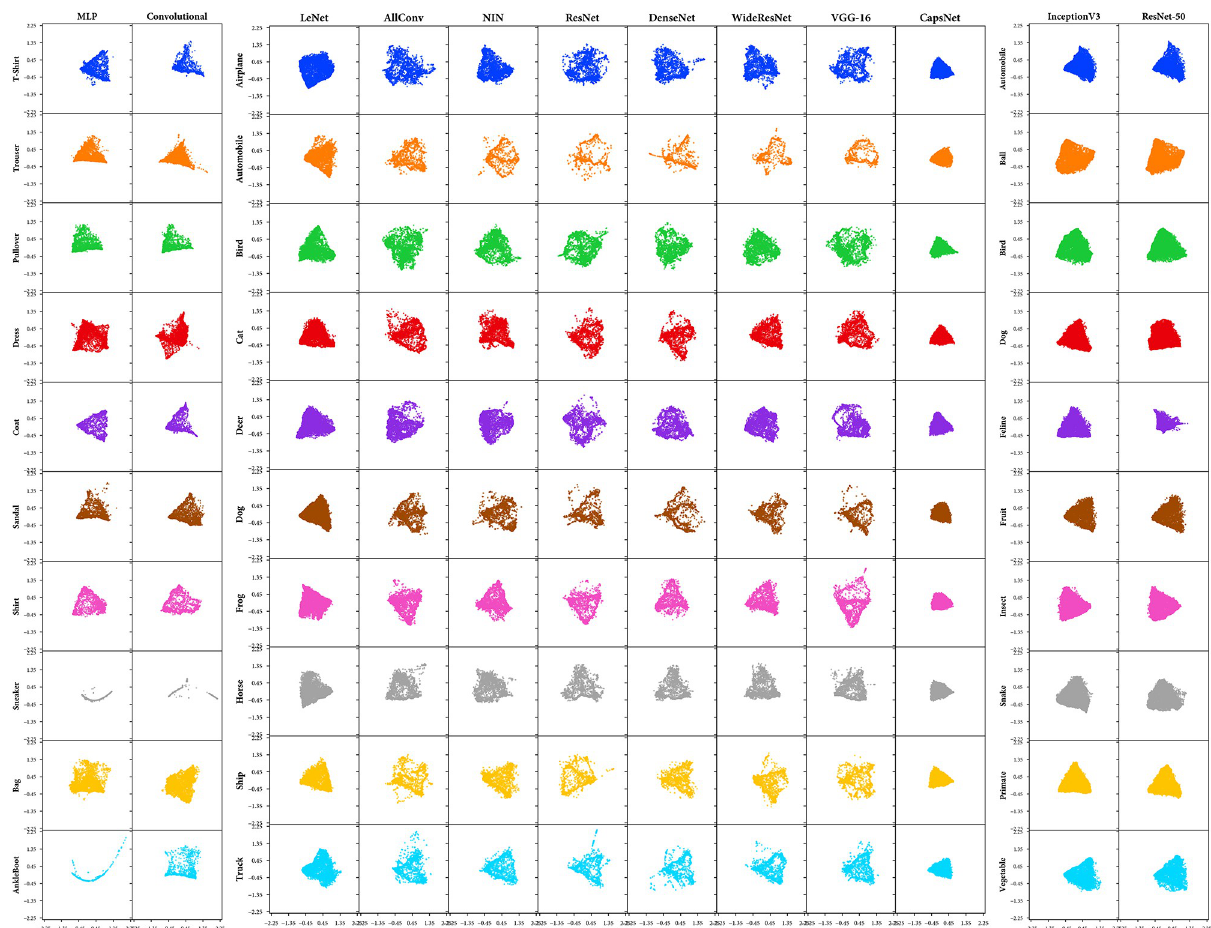
Fig 3. Visualisation of the Davies–Bouldin Metric (DBM) results for vanilla classifiers using a topology preserving two-dimensional projection with Isometric Mapping (Isomap). Each row represents a classifier trained with a label excluded whose projection is visualised. While each column represents a different classifier architecture evaluated. A denser clustering represents a consistent view of the unknown class by the architecture.